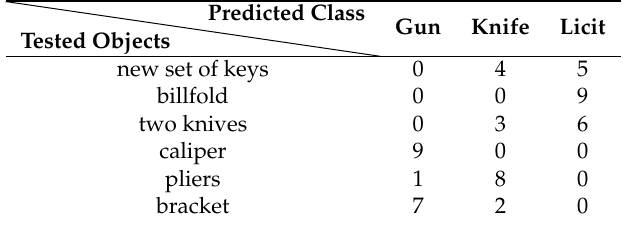
Table 12. Confusion matrix for additional objects; test phase only; 9 images among which 8 obtained by bootstrap. Tested